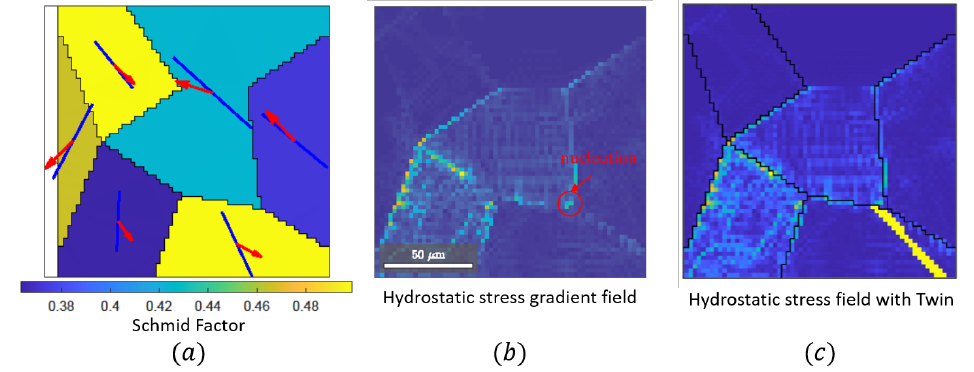
Figure 22. For a seven crystal system, ( a ) twin system with maximum Schmid values, ( b ) hydrostatic stress gradient field before twinning, and ( c ) twin nucleation of predominant twin system at site determined by hydrostatic stress gradient in